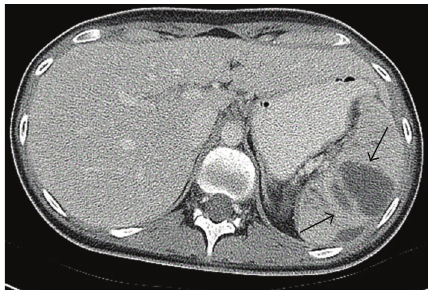
Figure 1: Splenic abscesses noted on CT scan (arrows).